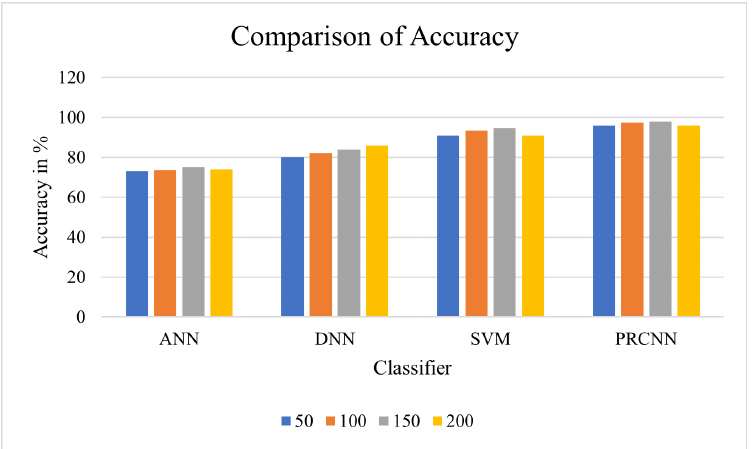
Figure 7. Comparison of accuracy.